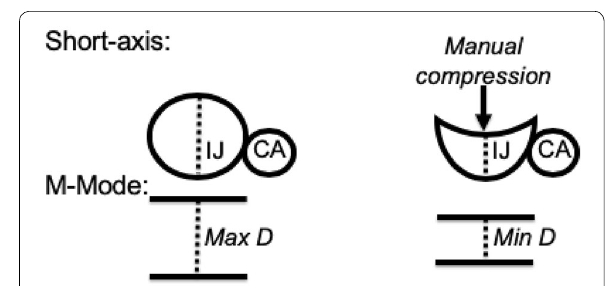
Fig. 2 Schematic representation of ultrasound findings in Short-axis and M-mode. 2-cm manual compression of the IJ is noted on the right panel of the figure. IJ internal jugular vein, CA carotid artery, Max maximum, D diameter, Min